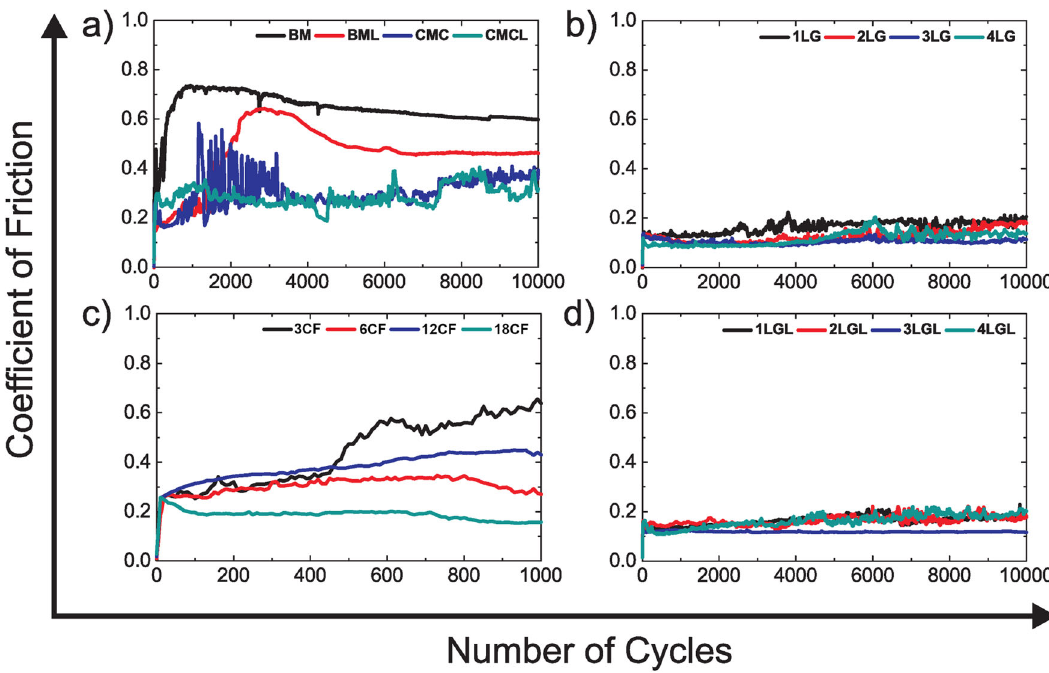
Fig. 3 Friction measurements. Representative friction curves for ( a ) BM, commercial medium with commercial ~2.7 nm COC (CMC), commercial medium with commercial ~2.7 nm COC and ~1.0 nm PFPE lube (CMCL), BM coated with ~1.2 ± 0.2 nm PFPE lube (BML). b HDM coated with 1 – 4LG. c HDM with FCVA-ta-C of different thicknesses with 0.3 (3CF), 0.6 (6CF), 1.2 (12CF), and 1.8 nm (18CF) FCVA-deposited ta-C. d HDM coated with 1 – 4LG and ~1.2 ± 0.2 nm PFPE lubricant